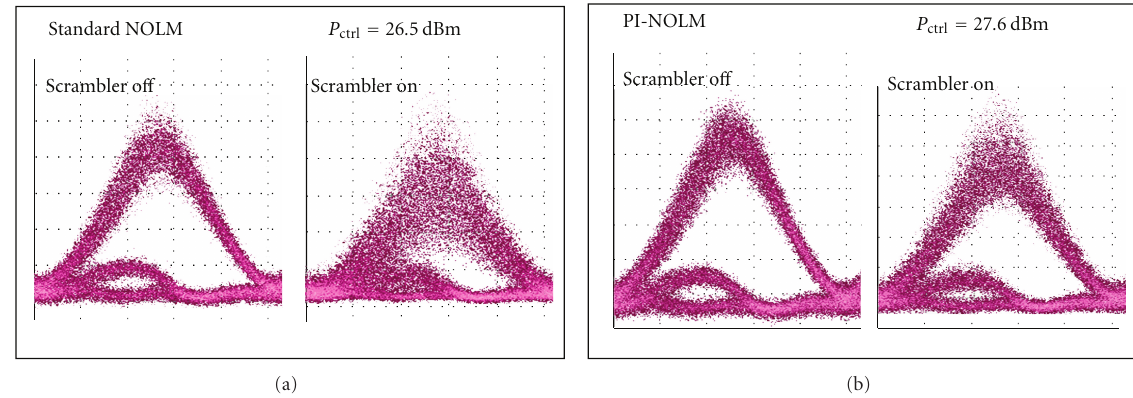
Figure 19: Eye diagrams for the demultiplexed 10Gbit/s signal for the (a) standard, and (b) PI-NOLM operations, with polarization scram- bler on and o ff .